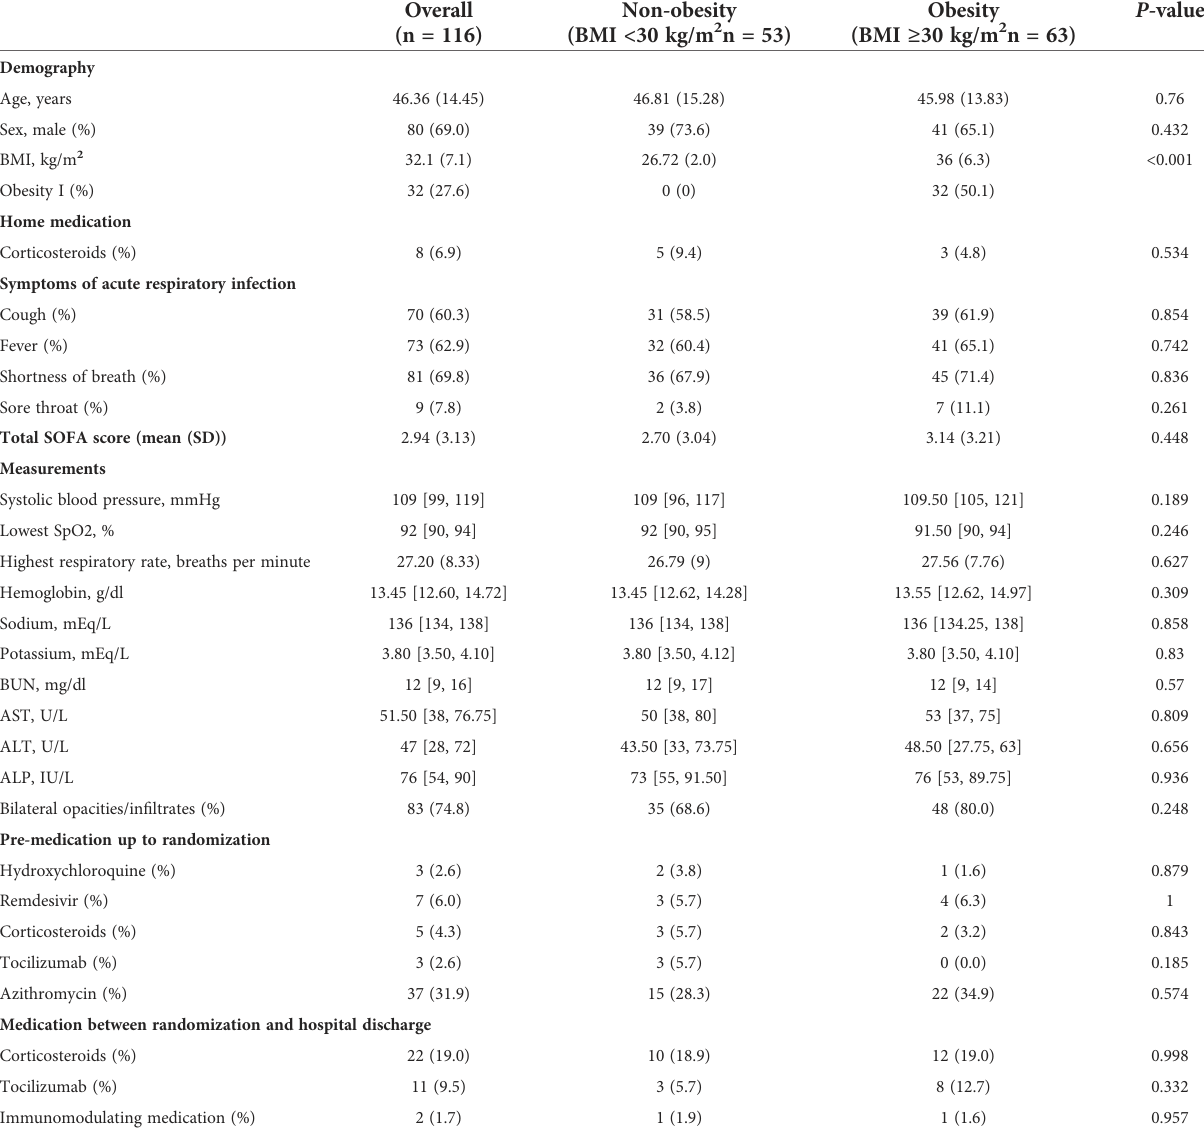
TABLE 1 Baseline characteristics of hospitalized patients with COVID-19 without comorbidities stori fi ed by